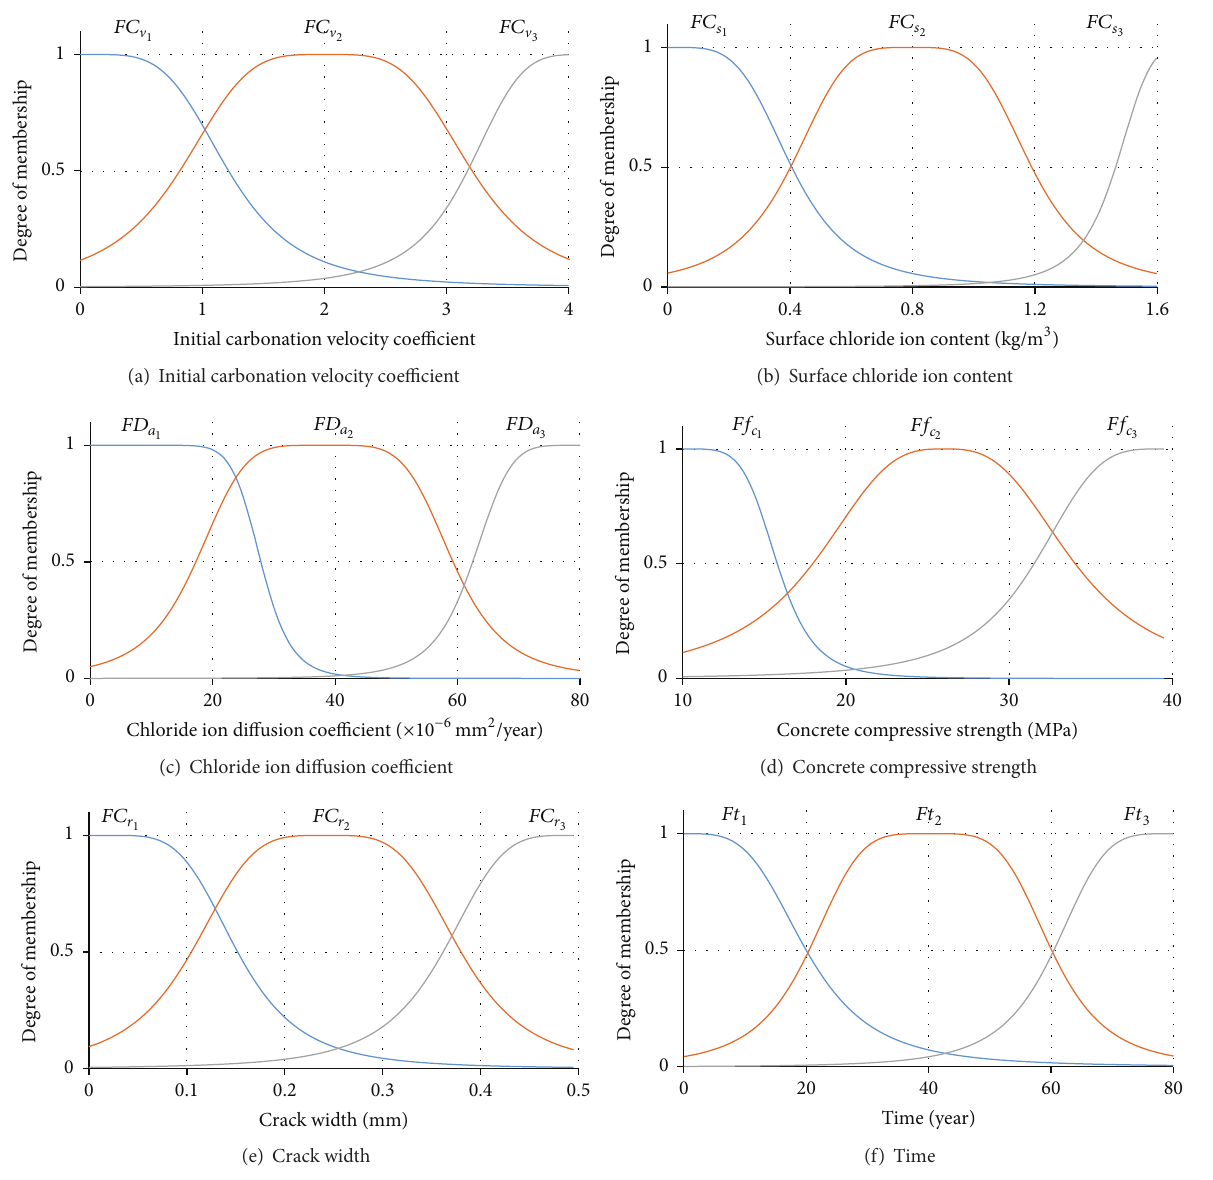
Figure 5: Fuzzy sets of input parameters after